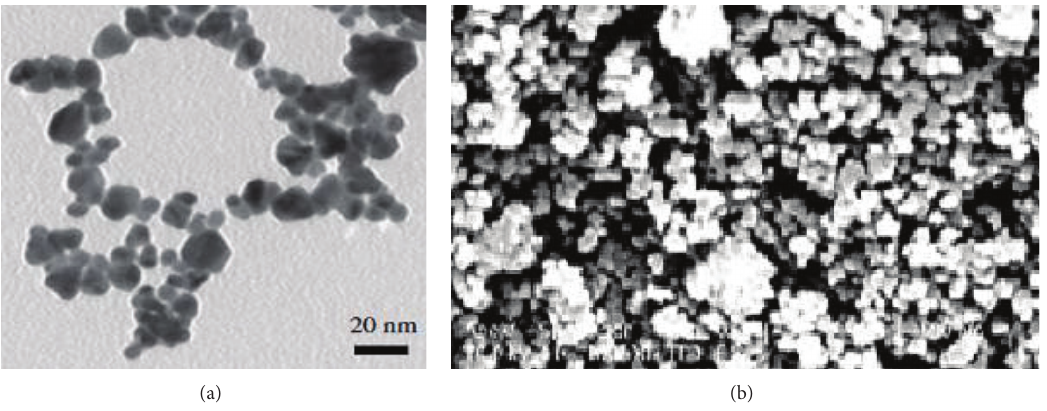
F 2: (a) TEM of ANP. (b) SEM of ANP.